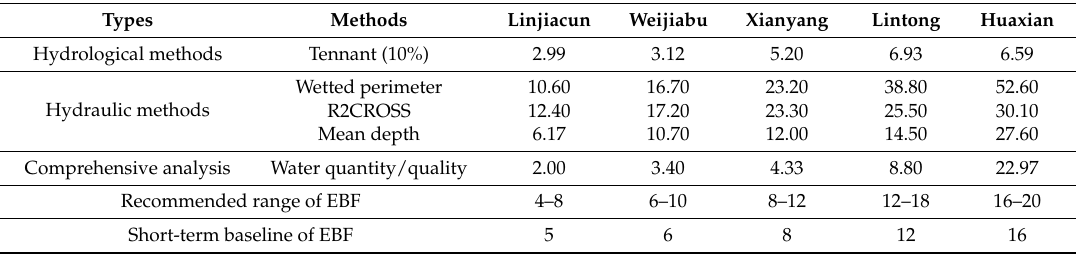
Table 4. The comparisons of recommended EBF estimated by 3 types of method at 5 stations in MSX, cited from [21] The unit is m 3